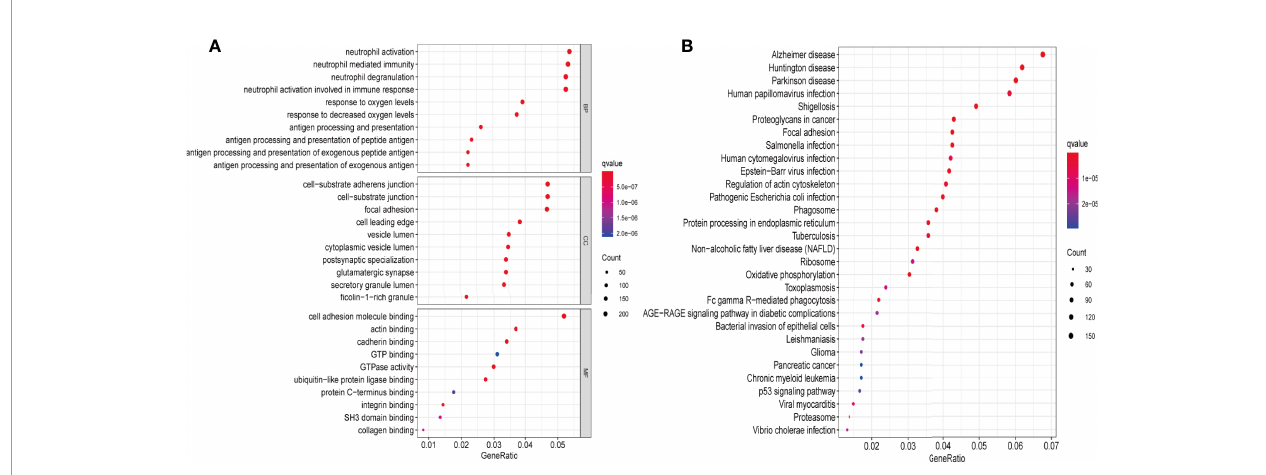
FIGURE 8 | PRLHR functional enrichment analysis. (A) The function of PRLHR in GO (biological process [BP], cellular component [CC], and molecular function [MF]) enrichment (top 10, p < 0.05); (B) KEGG pathway enrichment (top 30, p <